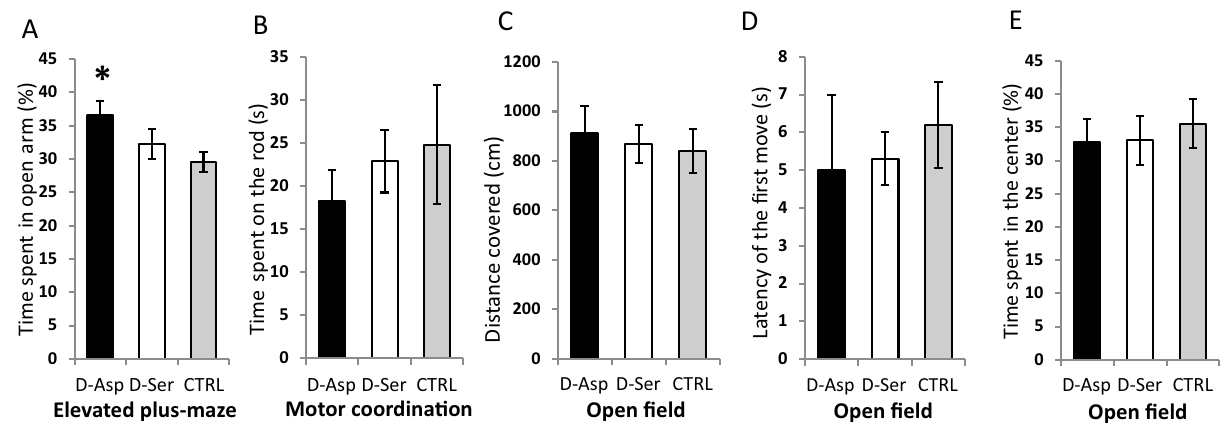
Figure 3. ( A ) d-Asp treated mice spent more time in the open arm of the elevated plus-maze than control animals (t = 2.61, P = 0.014). * P < 0.05. ( B ) Neither of the experimental treatment groups differed from the control when tested for motor coordination by a rod grip test (F 2,27 = 1.27, P = 0.297). ( C ) There was no significant difference in the locomotor activity of the treatment groups in an open field test (F 2,28 = 1,98, P = 0.157). ( D ) There was no difference between the groups regarding the latency of the first movement after placing the mouse in the middle of arena (F 2,28 = 0.901, P = 0.418). ( E ) There was no difference between the treatment groups in the time spent at the center of the open-field arena (F 2,28 = 0.18, P = 0.838).